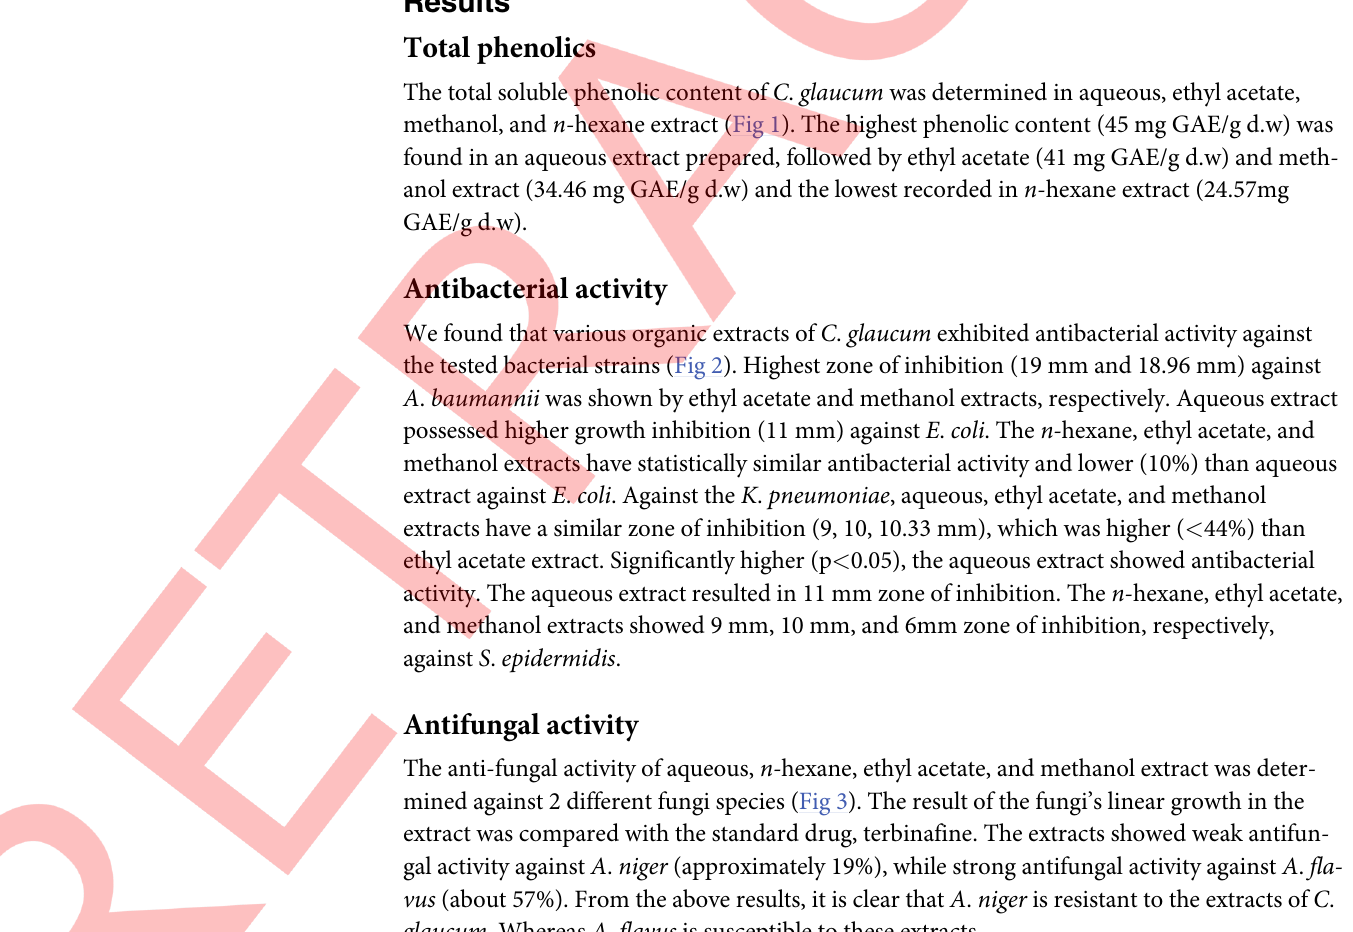
Fig 1. Total phenolics content of aqueous, methanol, hexane, and ethyl acetate extracts of C . glaucum .